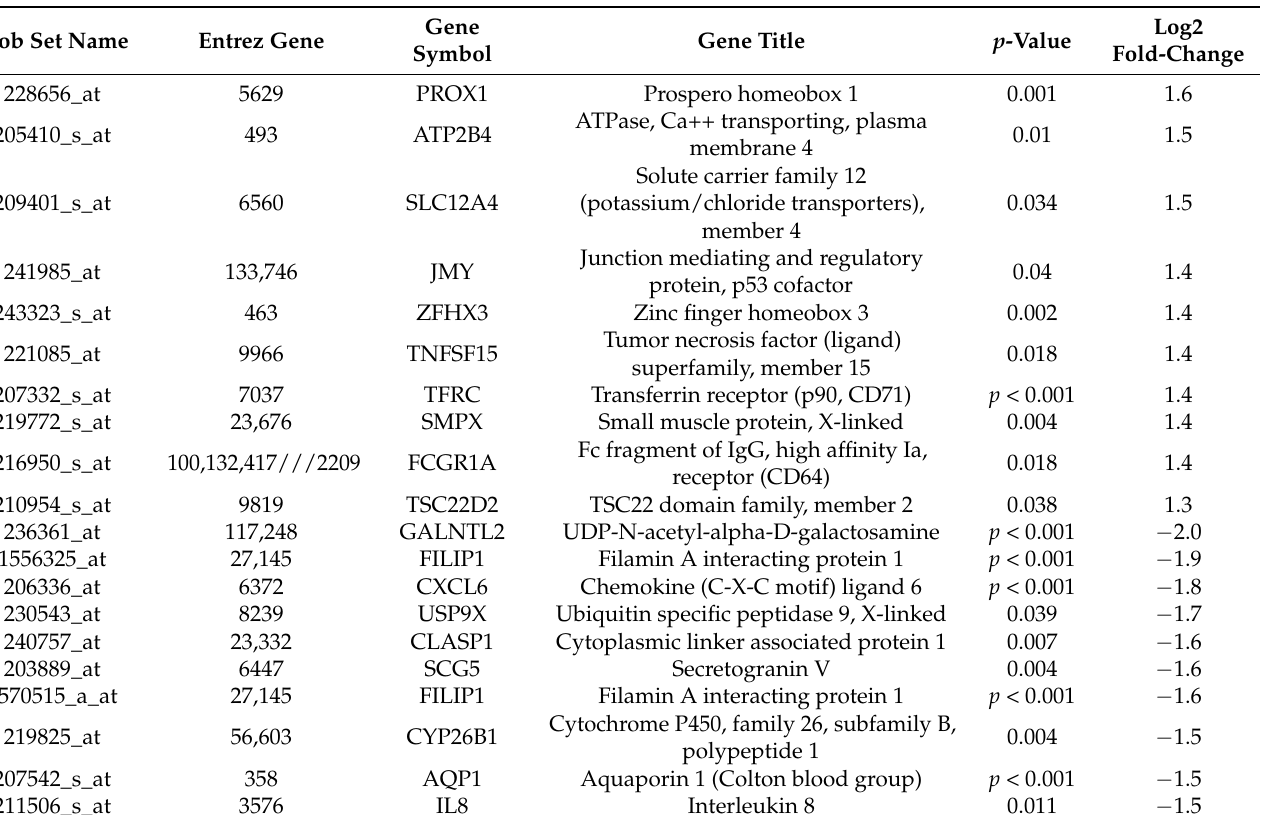
Table 2. List of top 20 genes based on fold change that were differentially expressed in HUVECs culture in 5 mM MgSO 4